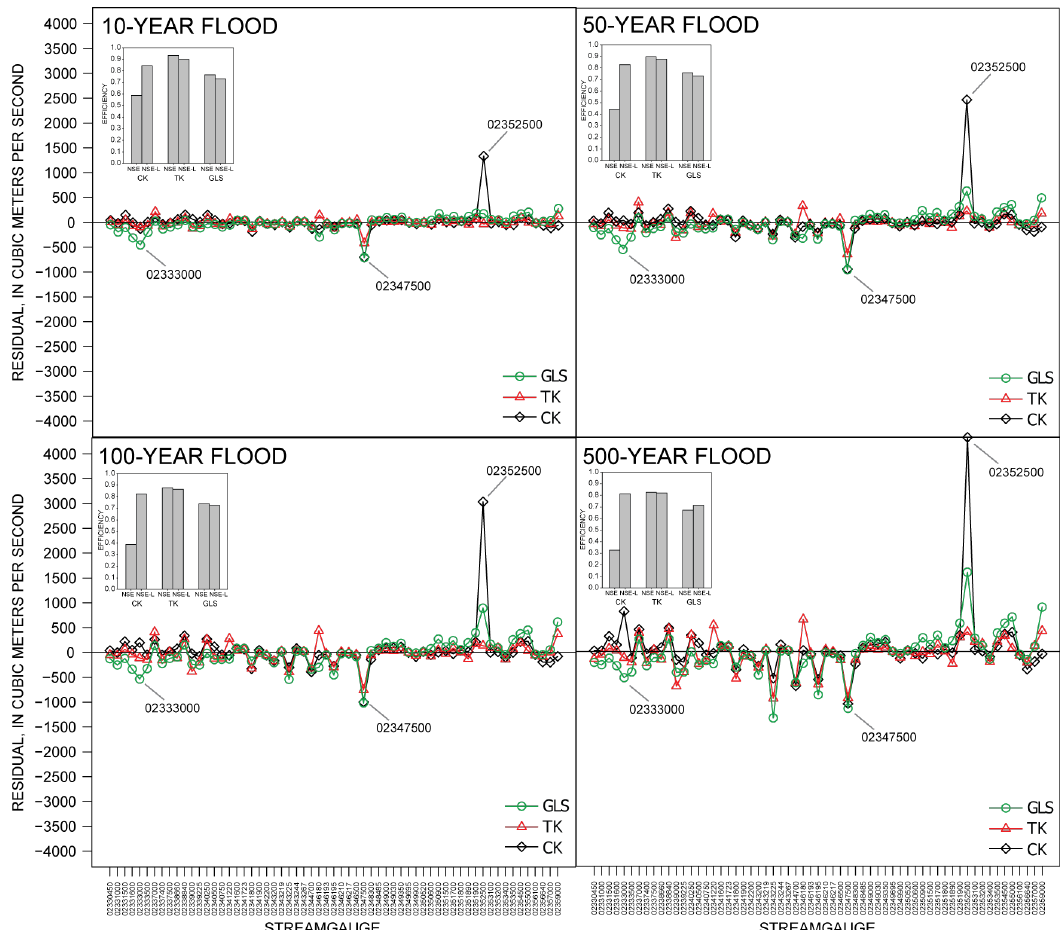
Fig. 3. Error (or residual) between the empirical and predicted flood quantile by study streamgauge and estimation method. Inset in each panel are bars showing the efficiency and log efficiency of the empirical and predicted flood quantiles for the generalized least squares regression, topological kriging, and canonical kriging methods. The log efficiency is the efficiency computed from the natural logarithms of the empirical and predicted flood